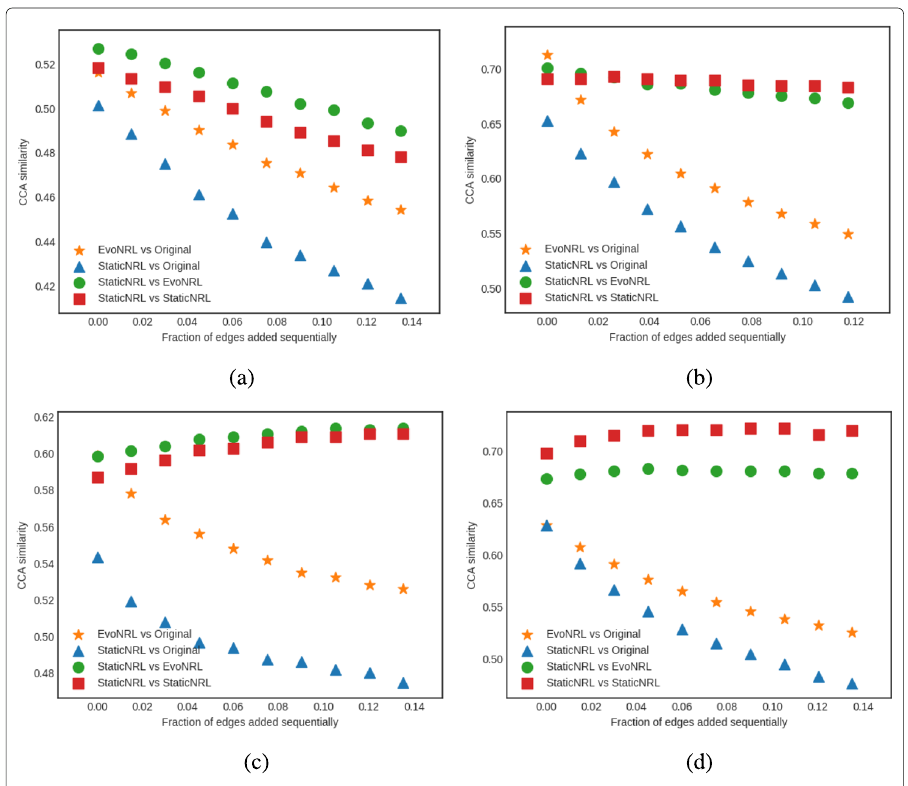
Fig. 7 Accuracy performance of E VO NRL — adding edges. a BlogCatalog, b PPI, c Facebook, d Cit-HepTh